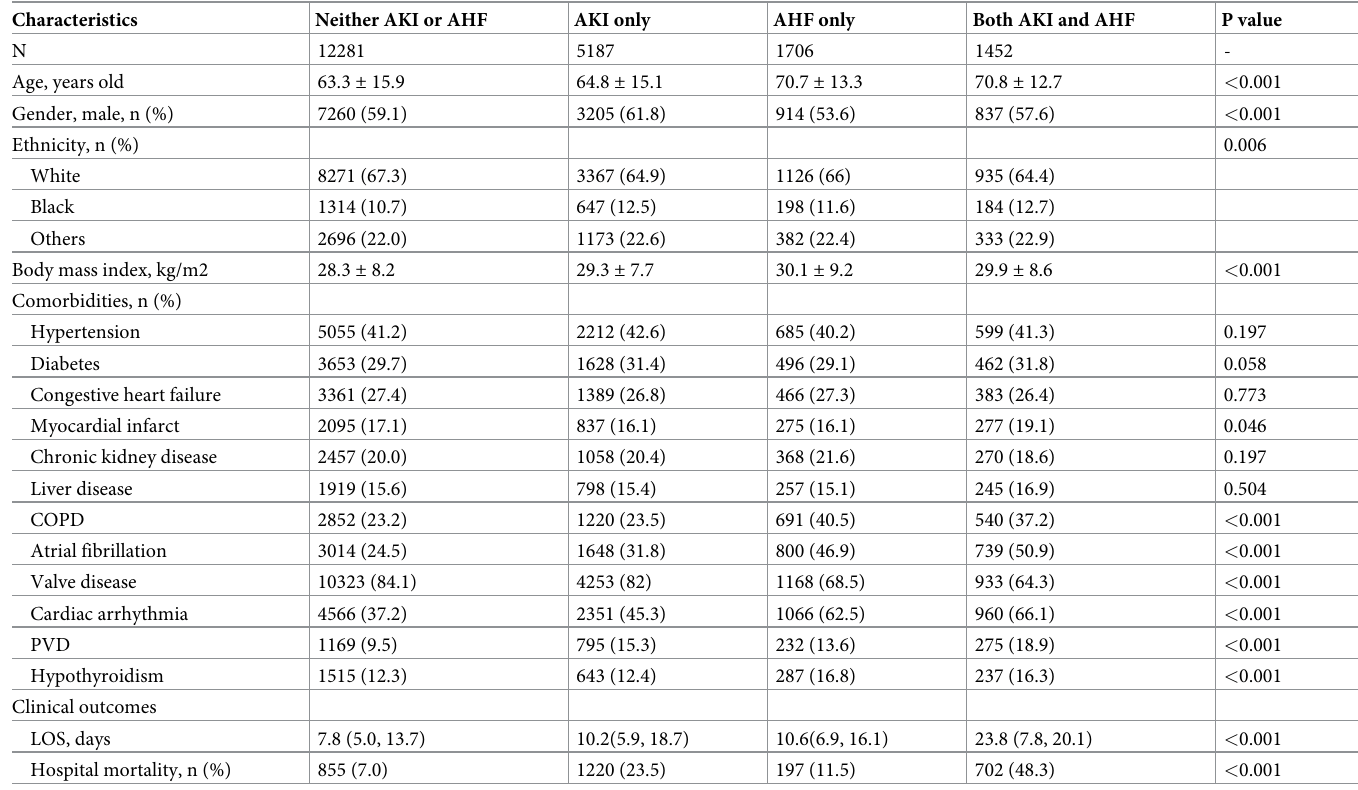
Table 1. The basic demographic and outcomes of all patients in training cohort categorized by AHF and